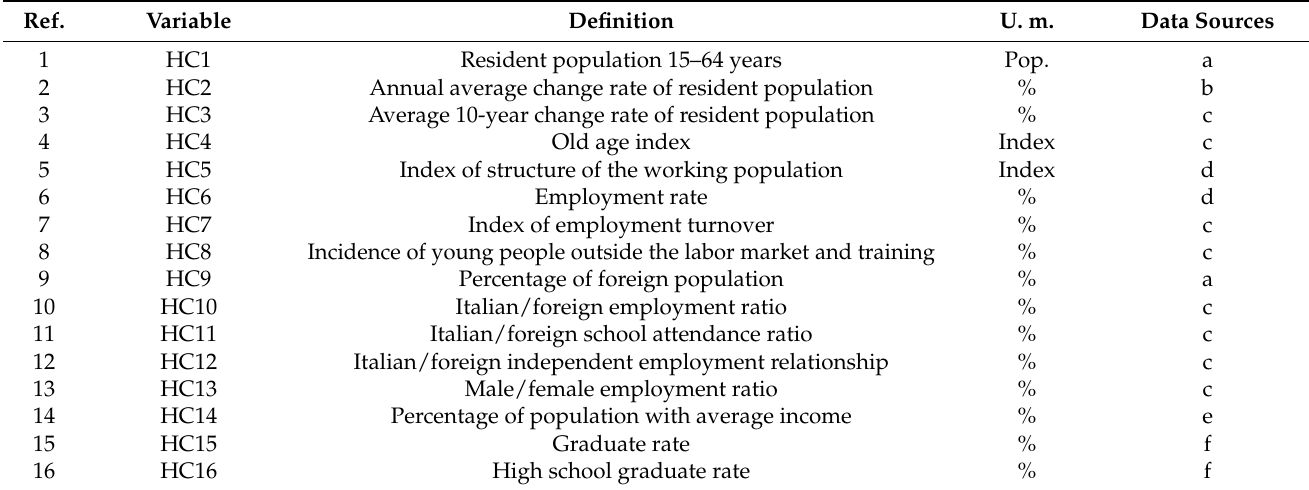
Table 1. Human capital indicators.